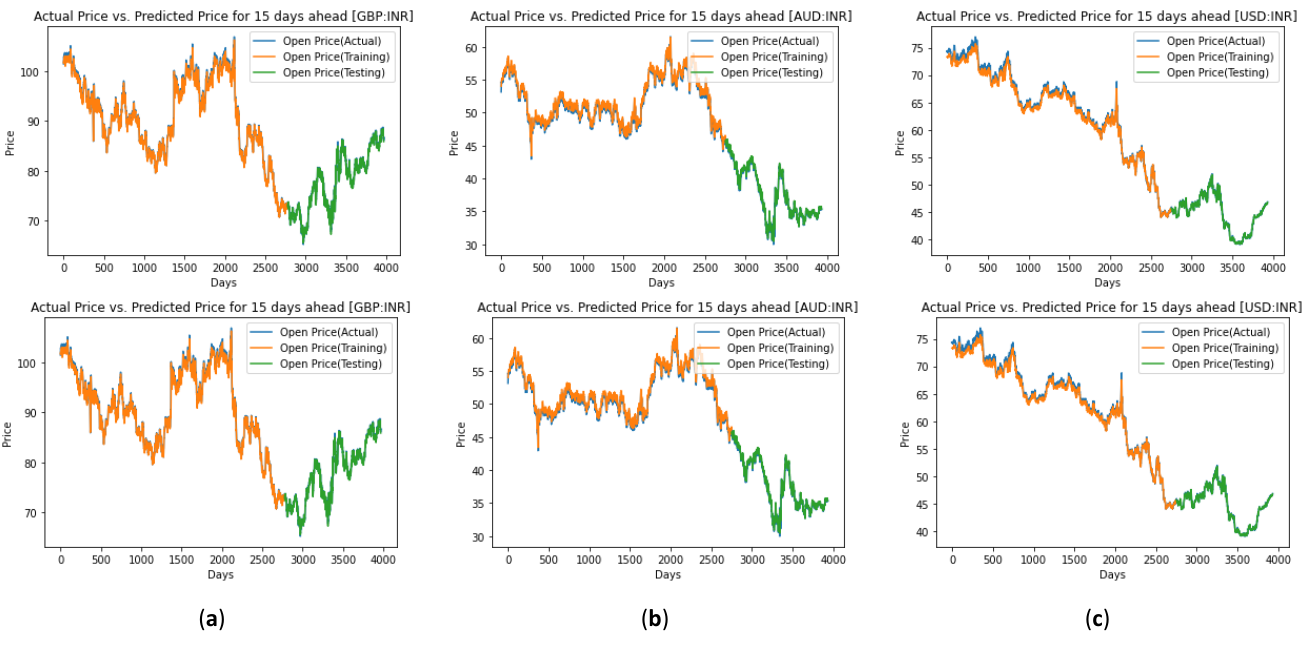
Figure 7. Short-term and long-term prediction graphs and MSE graphs using Conv-LSTM for ( a )